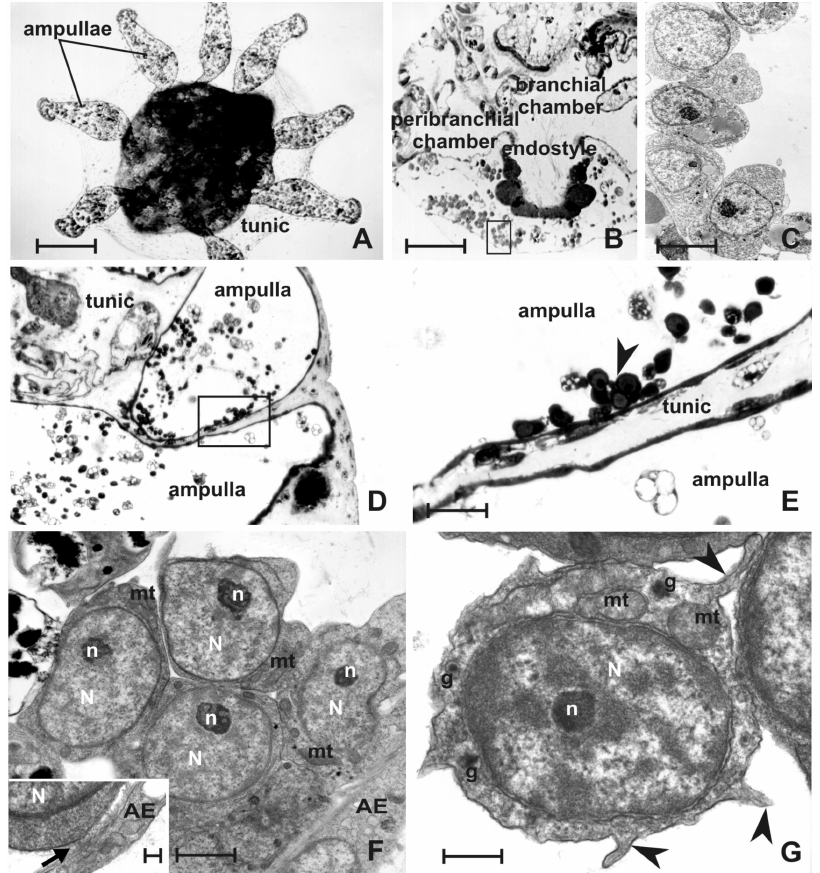
Figure 7. Oozoid: ( A ) individual at the end of metamorphosis viewed in toto, showing the maximum protrusion of the eight ampullae onto the substratum. Ampullae join with the vessels of the colonial circulatory system that are growing and arranging in the tunic; ( B ) transversal thick section at the level of the endostyle stained with toluidine blue. Note clusters of haemocytes in the subendostylar sinus; ( C ) ultrastructural detail of the selected area in ( B ) showing the presence of crowding haemoblasts; ( D ) longitudinal thick section at the level of ampullae; ( E ) detail of the selected area in ( D ) showing clusters of haemoblasts ( arrowheads ); and ( F , G ) ultrastructural images of these areas confirm the presence of groups of haemoblasts along the lateral epithelium of the ampullae ( F ), in which these cells adhere tightly to each other and with the basal lamina of the epithelium ( arrow in inset ). Speciali- sations such as granules and pseudopodia ( arrowheads ) are recognisable in haemoblasts facing the ampullar lumen ( G ). AE —ampullar epithelium, g —membrane-bound granule, mt —mitochondrion, N —nucleus, and n —nucleolus. Bar length: 65 µ m in ( A ); 130 µ m in ( B ); 5 µ m in ( C ); 120 µ m in ( D ); 8 µ m in ( E ); 1.7 µ m in ( F ); 0.7 µ m in ( G ); and 0.3 µ m in inset of ( F